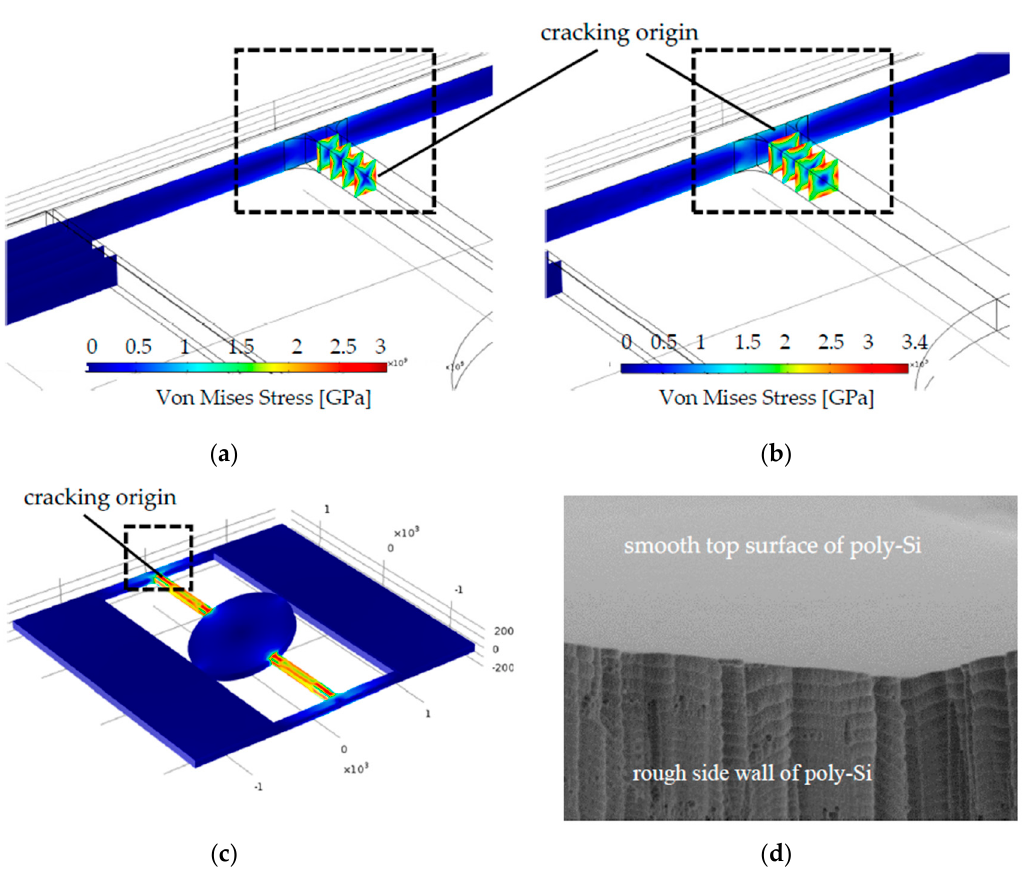
Figure 8. Sectional view of simulation of Design S: ( a ) Design S1 with a rectangular torsion bar ( b / t = 0.75) and the maximum bearable Von Mises Stress is 3 GPa; ( b ) Design S2 with a square torsion bar ( b / t = 1) and the maximum bearable Von Mises Stress is 3.4 GPa; ( c ) Top view of Design S; ( d ) SEM picture of a torsion bar with smooth top surface and rough side wall of poly-Si.